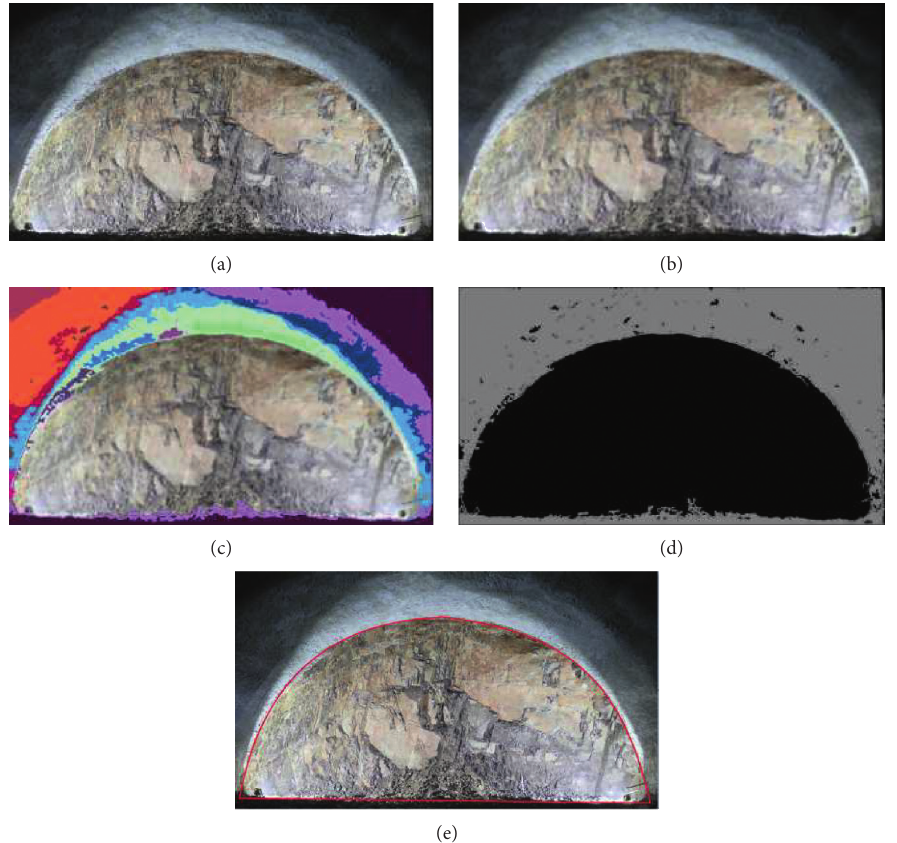
Figure 4: Extraction of tunnel face area from the image. (a) The original image of tunnel face. (b) The image after Gaussian filtering. (c) The image after region growth processing. (d) The area of tunnel face extracted. (e) The result after image preprocessing.